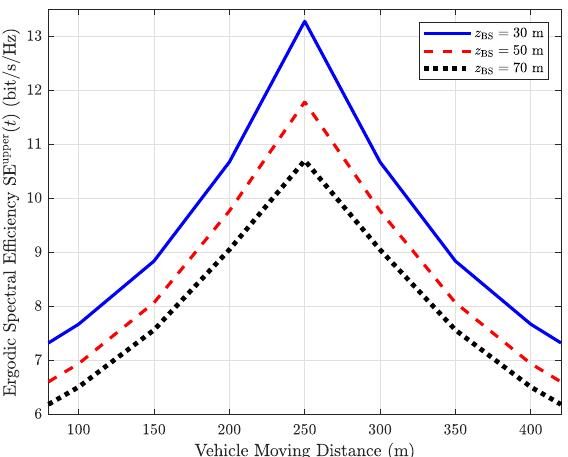
Figure 9. Ergodic SEs for different positions of the BS.